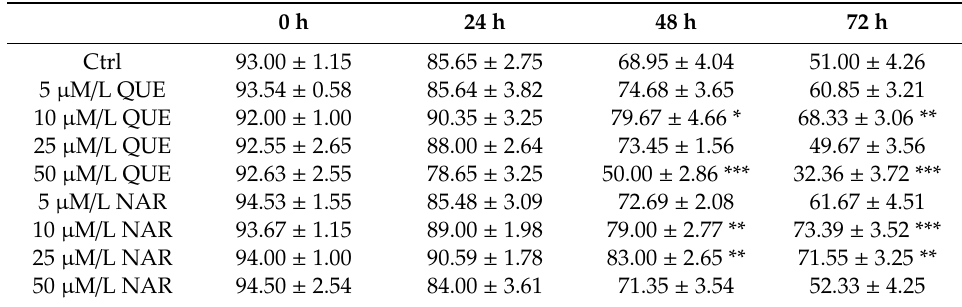
Table 3. Acrosome integrity (%) of extended boar spermatozoa following exposure to quercetin or naringenin ( n = 28).